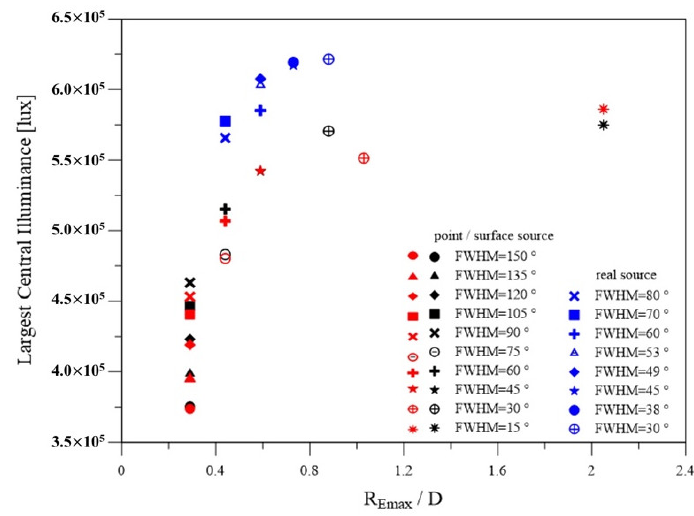
Figure 11. Largest central illuminance (LCI) with respect to observation distance-to- luminaire dimension ratio in hollow array (red dots: point source, black dots: flat extended source, blue dots: LED module).